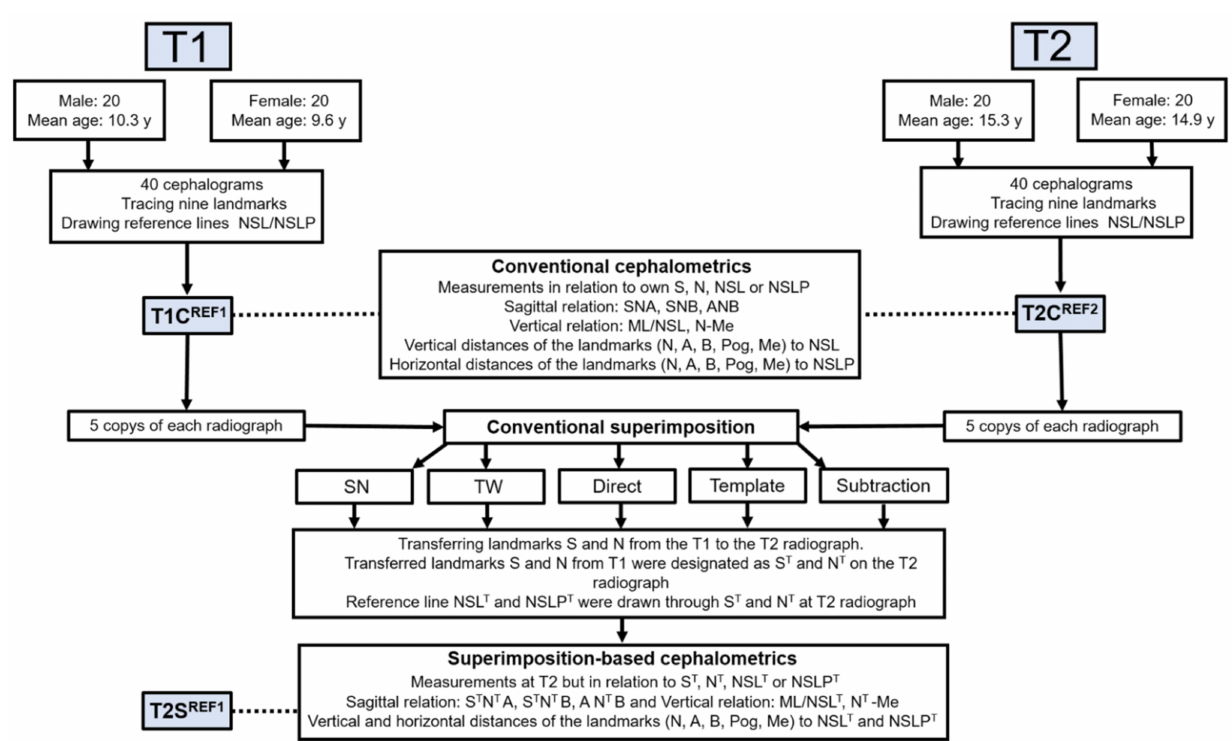
Figure A2. Workflow for the different superimposition